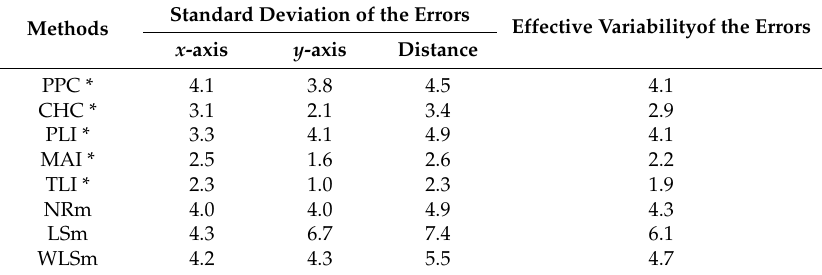
Table 3. Standard deviation of the